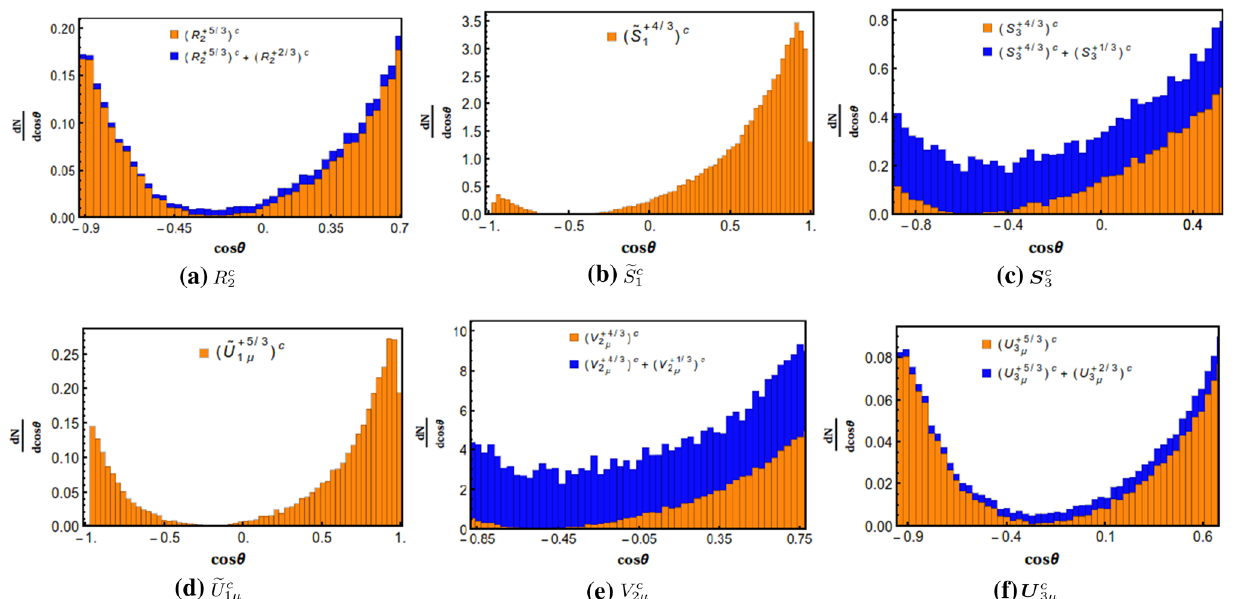
Fig. 16 Distribution of cosine of the angle made by the photon with the angular distribution for associated production of the corresponding √ s = 1183 . 2 GeV and L int = 2000 fb − 1 . The the electron beam, at leptoquarks along with a photon at LHeC sub-figures (a) R c , (b) (cid:8) S c , (c) S c , (d) (cid:8) U c , (e) V c and (f) U c show 2 1 3 1 μ 2 μ 3 μ Table 13 Signal-background analysis for associated production of photon and different leptoquarks at LHeC with = 2000 fb − 1 . The value of Q threshold L has been chosen − 0 . 3 for all the doublet and triplet leptoquarks int Jet